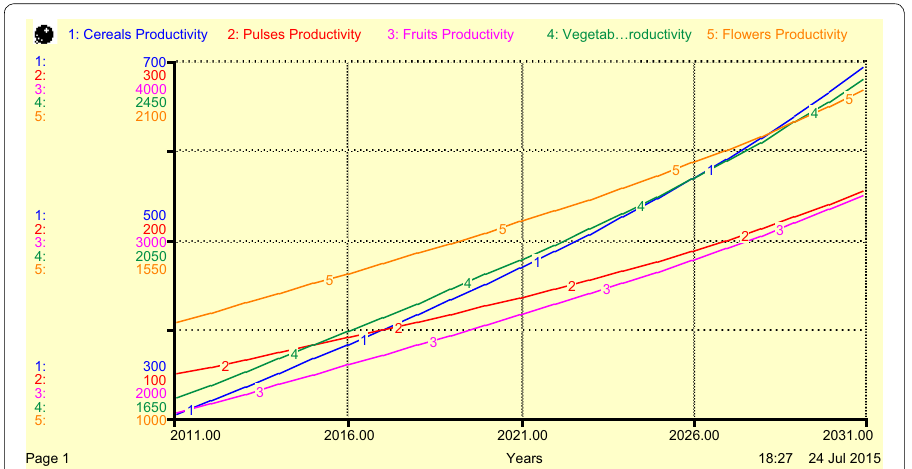
Fig. 19 Perceived projected production of cereals, pulses, fruits, vegetables, and flowers